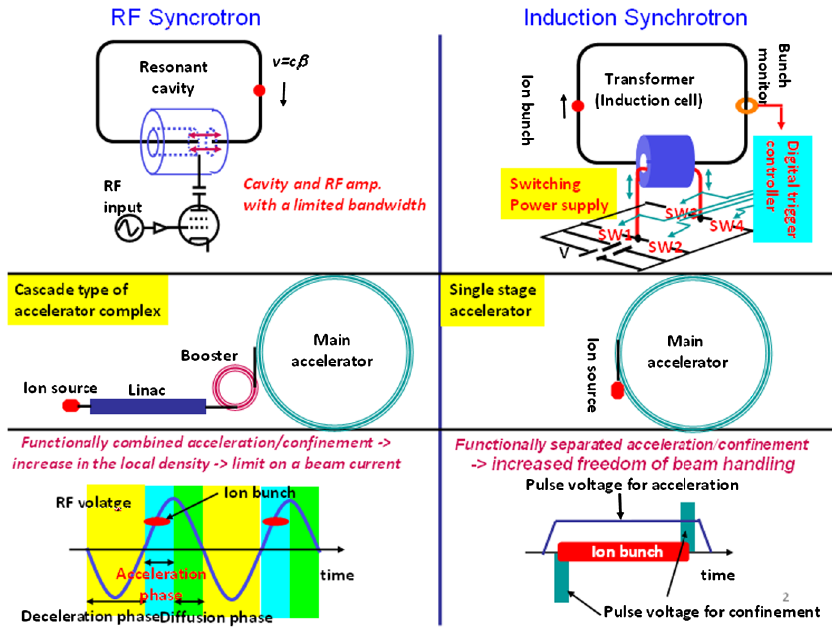
FIG. 1. Comparison between an rf synchrotron and an induction synchrotron (digital